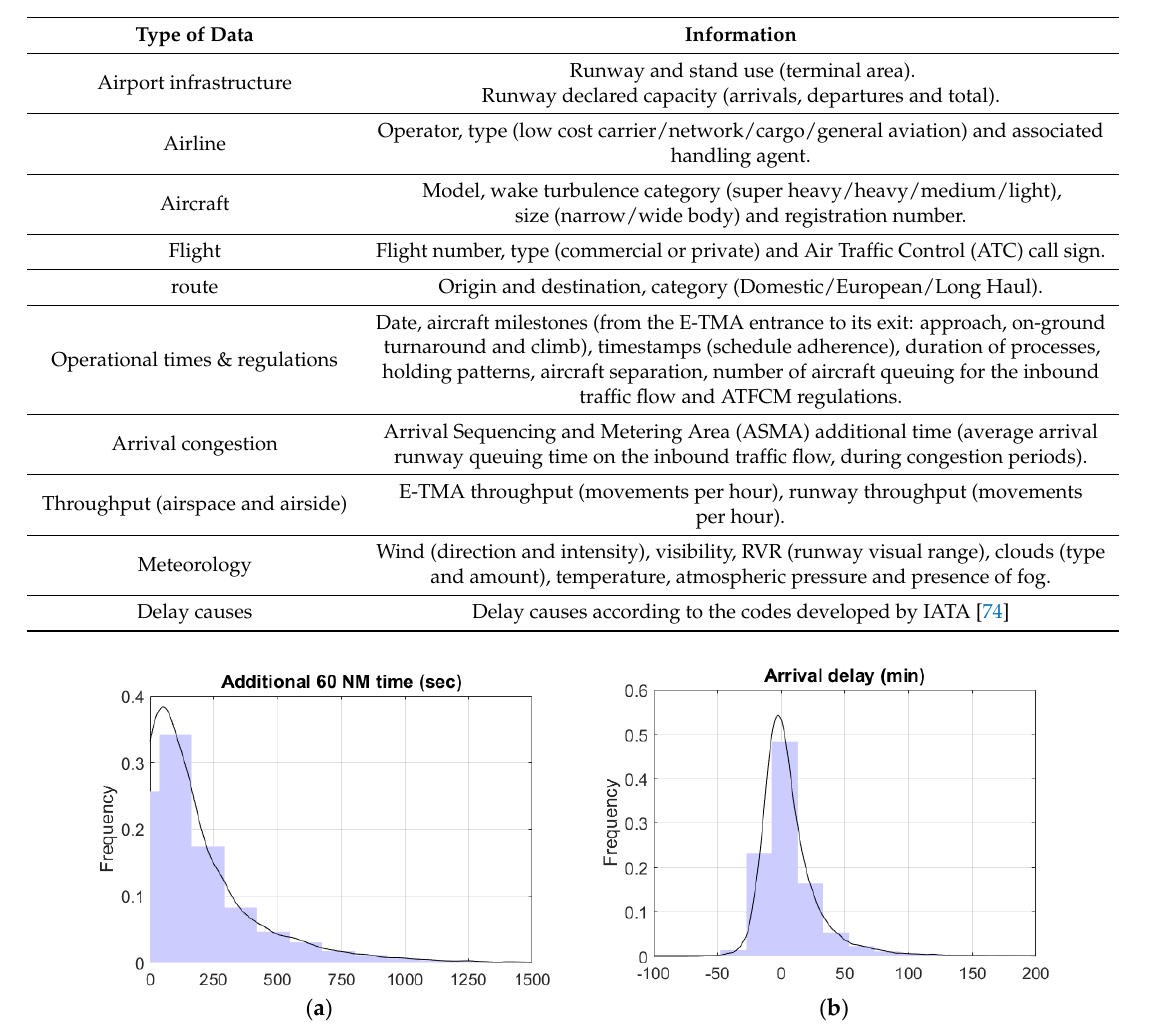
Table 3. Information included in the final dataset (obtained from raw data or derived from it).